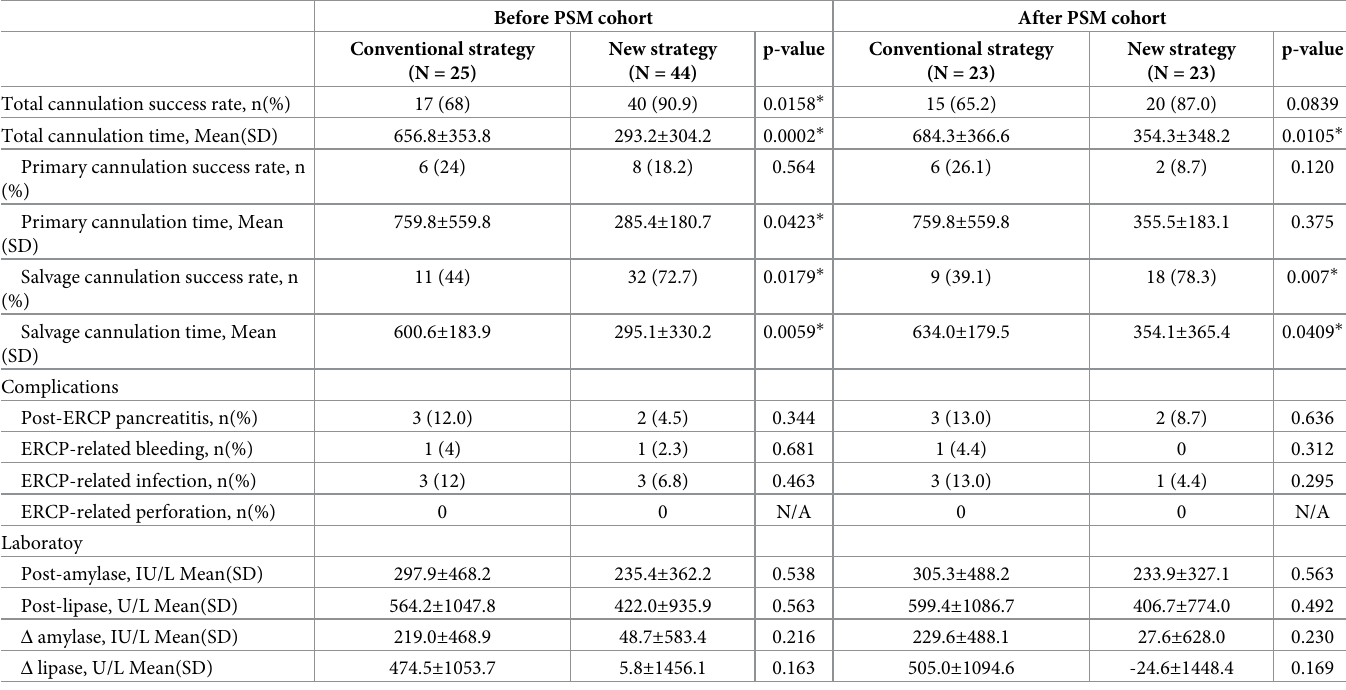
Table 3. Subgroup analysis of the outcomes between two strategies in the difficult cannulation group.